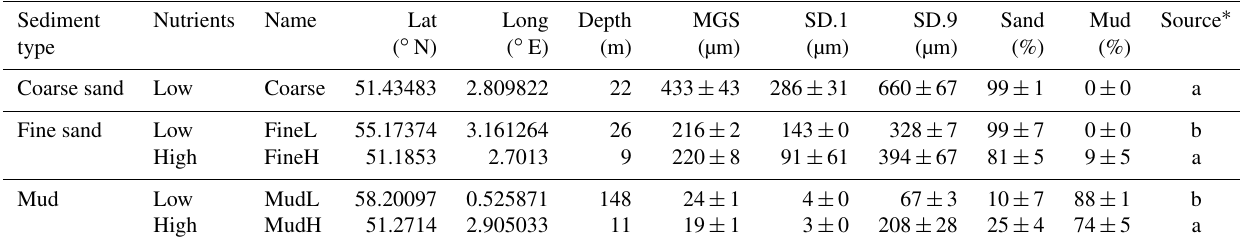
Table 2. Characteristics of the selected sites. Low and high nutrient classification is based on relative differences in nutrient build-up for the same sediment type (see Fig. S1 in Supplement). MGS, SD.1, and SD.9 are median grain size and the boundaries of the 10th and 90th percentile of the grain size respectively (in µm). The percentages of sand (63–1000µm) and mud ( < 63µm) are weight percentages of a dried sediment sample sieved over a 1mm